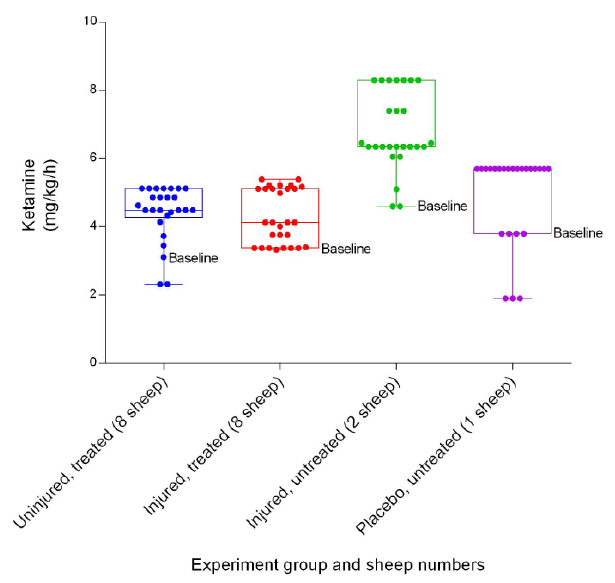
Figure 42. Ketamine IV infusion (Mean ± SD) indicating the titration range in smoke and non-smoke injured sheep that received extracorporeal life support as compared to that in untreated controls over a 24h period.